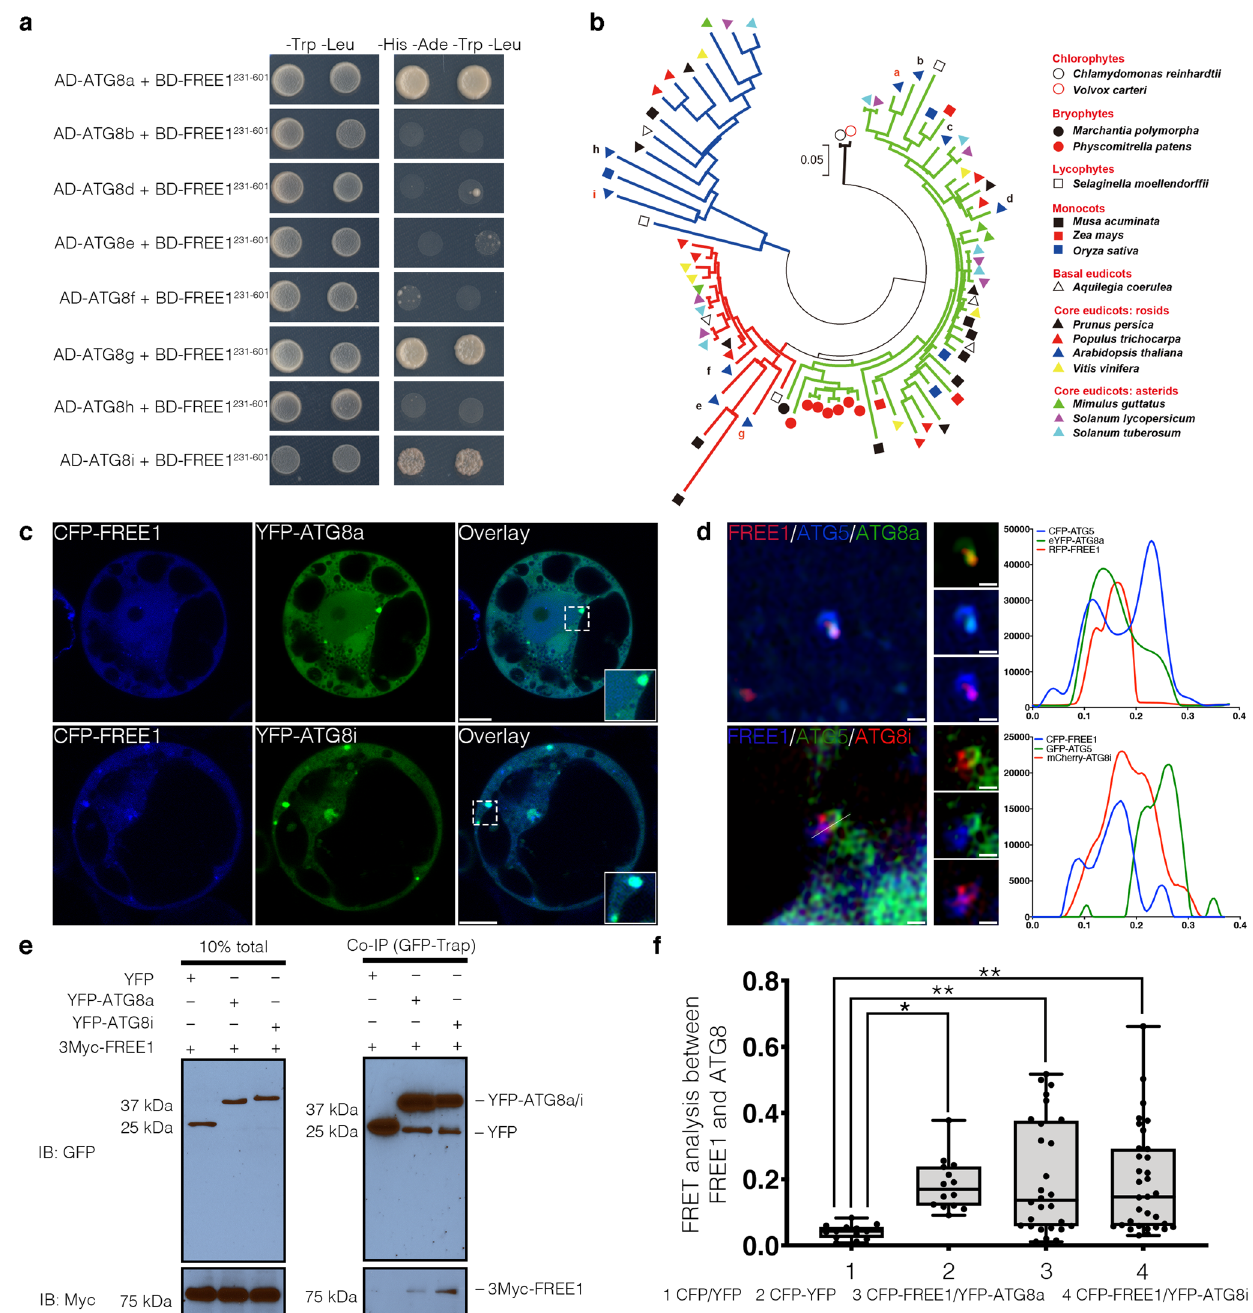
Fig. 3 | FREE1 speci fi cally interacts with the distinct paralogs of ATG8. a Y2H analysis of BD-FREE1 231 – 601 (the truncated FREE1 without self-activation on BD vec- tor) with AD-ATG8 isoforms. b Evolutionary relationships of ATG8 isoforms. The optimaltreewiththesumofbranchlength=4.32642842isshown.Thetreeisdrawn to scale, with branch lengths in the same units as those of the evolutionary dis- tancesusedtoinferthephylogenetictree. c TransientexpressionofCFP-FREE1with speci fi c ATG8 isoforms YFP-ATG8a and YFP-ATG8i in Arabidopsis protoplasts, the transfected protoplasts were cultured for 24h before CLSM observation. White dash boxes indicate the 2.5 X enlarged insets. Scale bars, 10 μ m. d Arabidopsis protoplasts transfected with FREE1, ATG5 and ATG8a or ATG8i were subjected to structure illuminated microscopy (SIM) analysis. Scale bars, 1 μ m. e GFP-Trap and co-immunoprecipitation (co-IP) analysis of 3Myc-FREE1 with YFP-ATG8a or YFP- ATG8i using Arabidopsis protoplasts. Arabidopsis protoplasts co-expressing 3Myc- FREE1 with YFP-ATG8a, YFP-ATG8i, or YFP only were subjected to protein